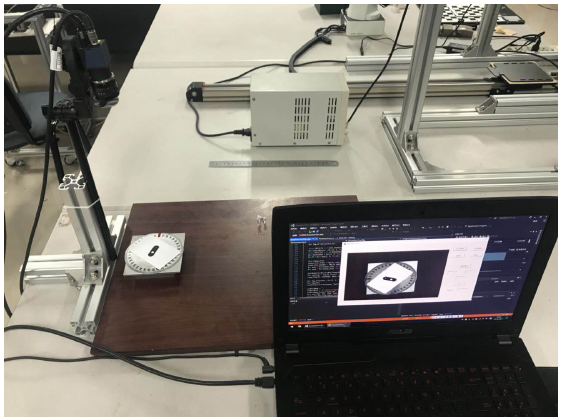
Figure 6. Experimental set up of the LIRS assessment system.